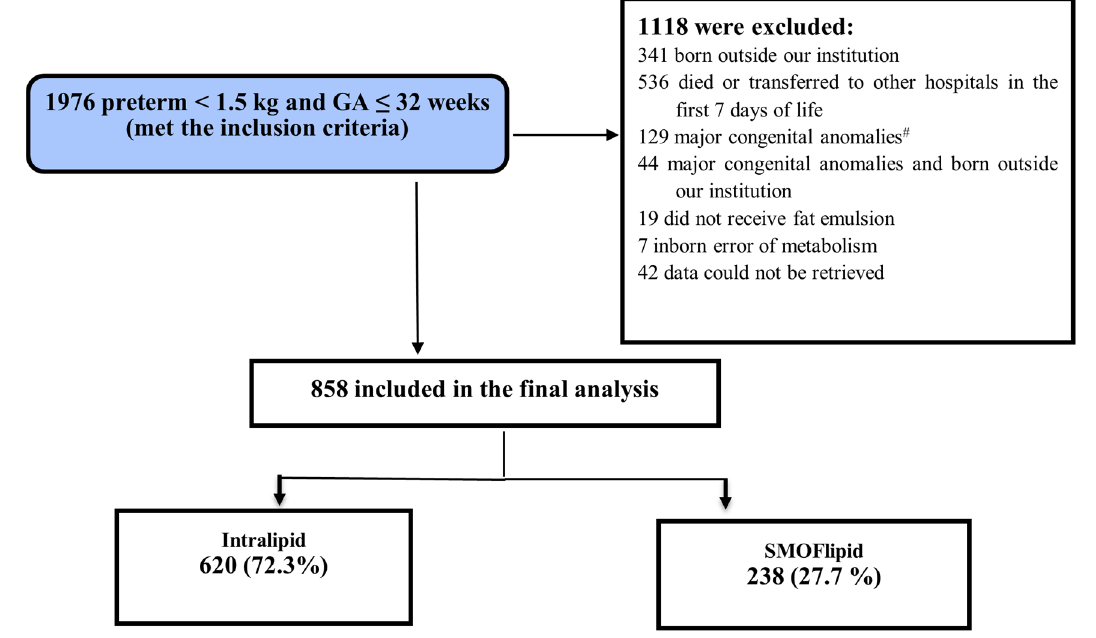
Figure 1. Flow chart of study participants. Among 858 infants, 238 received SMOFlipid and 620 were in the intralipid group. Table 1. Maternal and neonatal characteristics of study participants with SMOFlipid and Maternal and neonatal characteristics are summarized in Table 1. There were higher per- centage of cesarean deliveries in the SMOFlipid–LE group compared with the intralipid group. The Apgar scores at 1 and 5 min were higher in infants who received SMOFlipid compared with the intralipid group. In addition, infants who received SMOFlipid re-